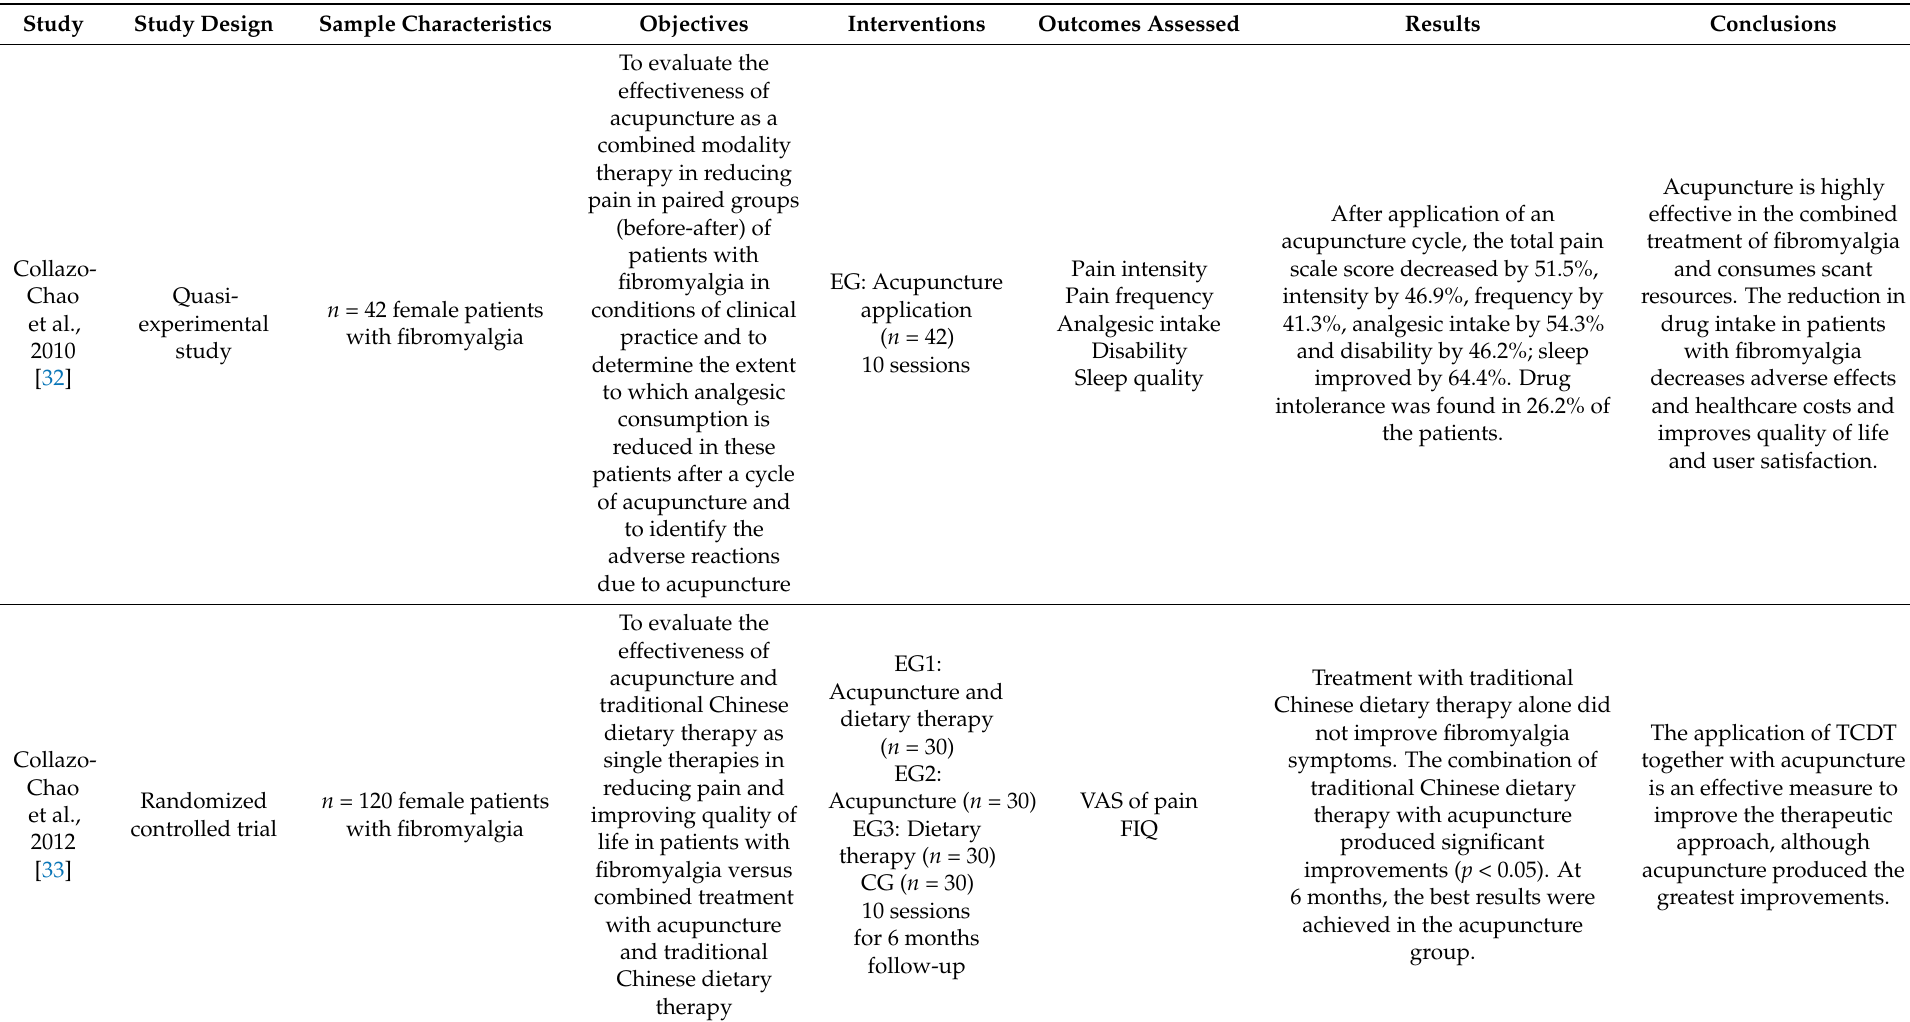
Table 3. Data Synthesis of the Studies applying Acupuncture in Patients with